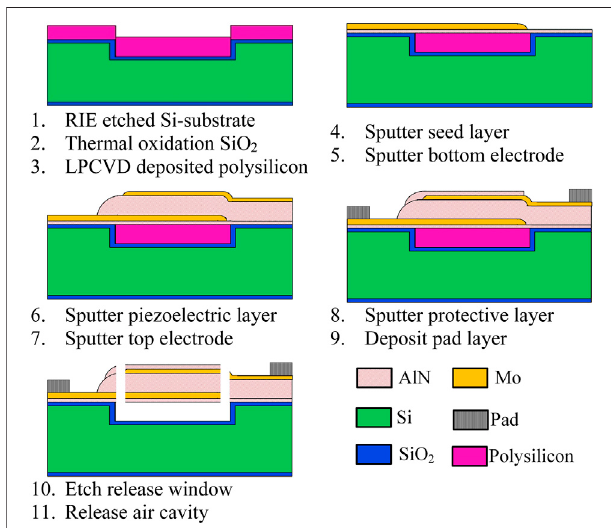
FIGURE 6 | Schematic of the fabrication process of FBAR.